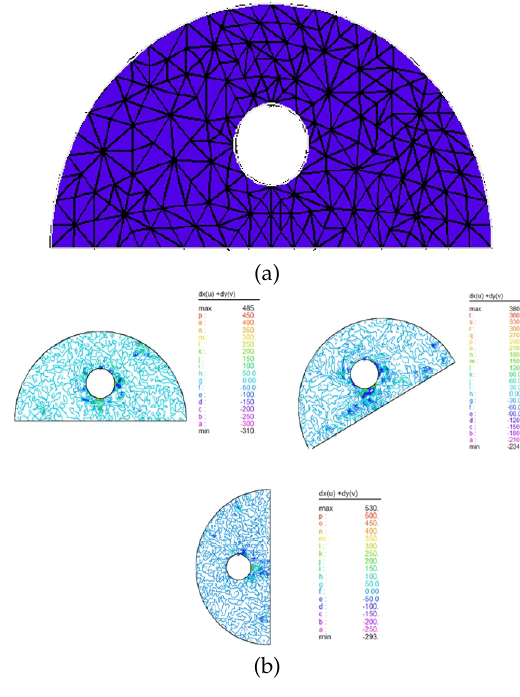
Fig. 2. Validation of continuity equation; (a) the grid of the domain and (b) the counter of the continuity equation Table 1. Comparison of Nu average number with Ref.[8]